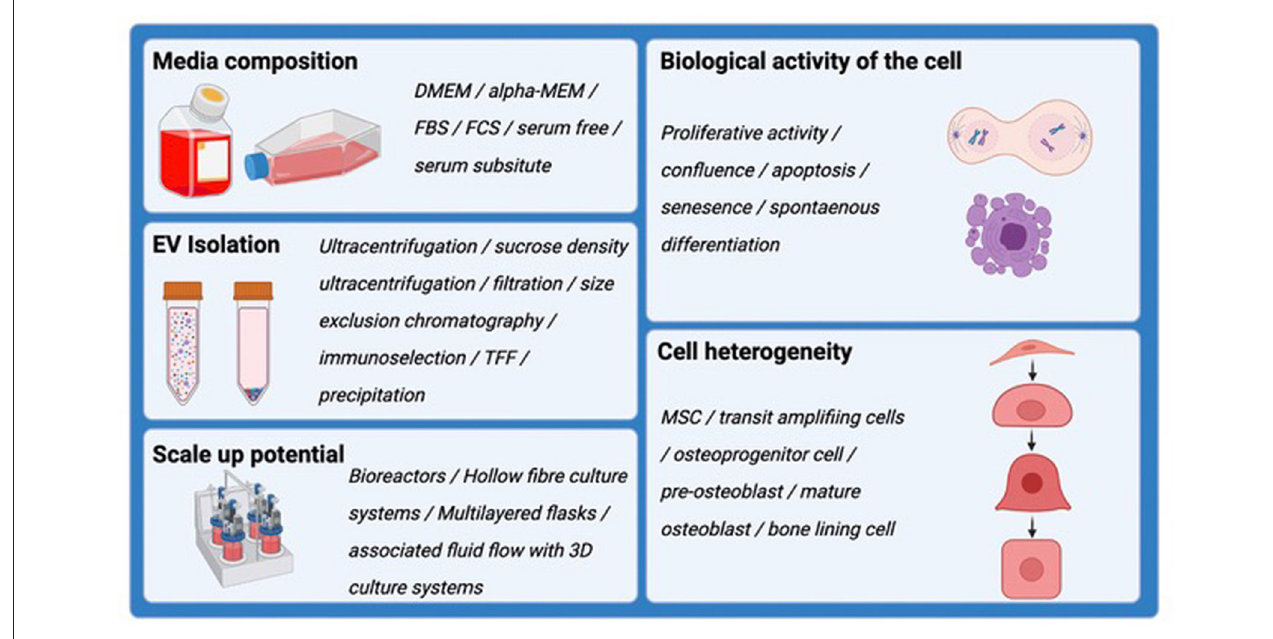
FIGURE 2 | Schematic demonstrating the factors that alter the quality and quantity of EVs produced by cells in vitro . These should all be considered when harvesting EVs for downstream analysis and therapeutic